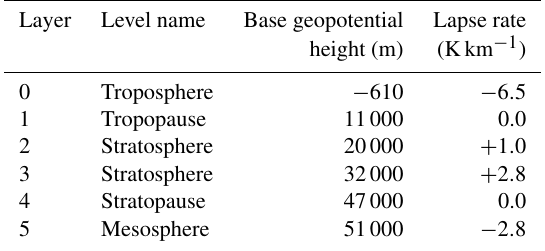
Table 2. International Standard Atmosphere (ISA) layers and lapse rates up to 71km geopotential